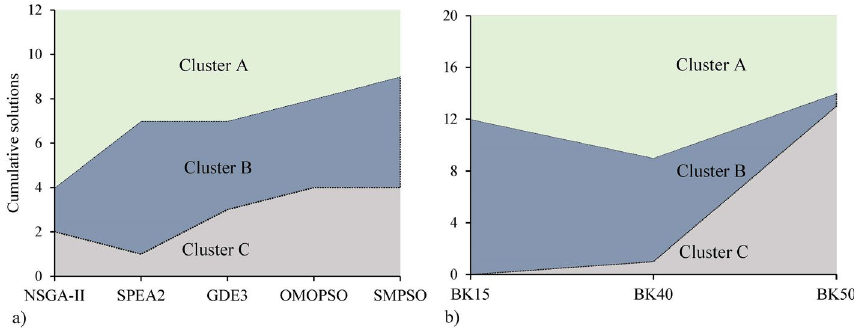
Figure 14. Distribution of obtained solutions among clusters with respect to: ( a ) algorithms ( b )